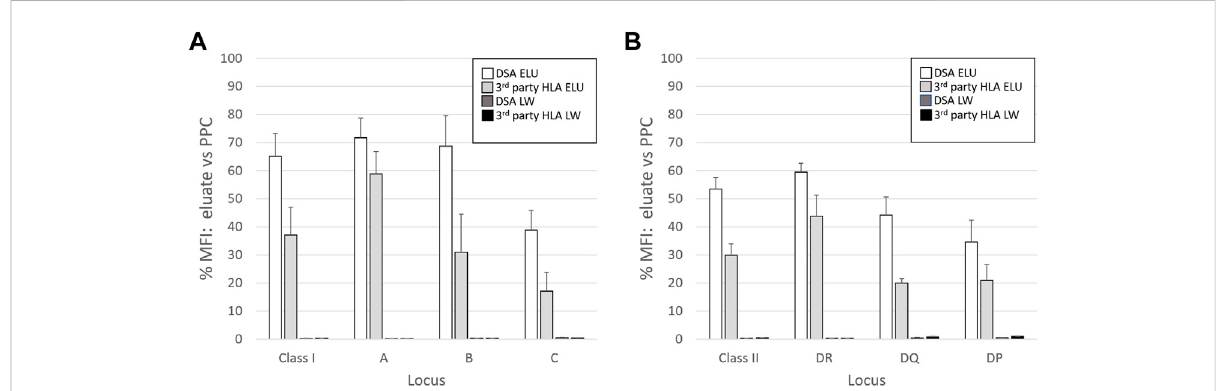
FIGURE 3 Theef fi ciencyofadsorption/elutionbyAXEisHLAlocusdependent.Themeanef fi ciency(%MFIcomparedtoserum)ofAXEadsorption/elution of DSA (DSA ELU; white bars) and 3 rd party HLA speci fi cities (3rd party HLA ELU; light grey bars), as well as the mean residual reactivity (% MFI compared to serum) in the last wash controls for the DSA (DSA LW; dark grey bars) and 3 rd party HLA speci fi cities (3 rd party HLA LW; black bars) are shown for class I (A) and class II (B) locus speci fi c HLA antibodies. The results are a mean +/- SD of separate experiments in which the AXE method was used to adsorb/elute HLA antibodies from PPC sera (1:128 dilution for class I and 1:8 dilution for class II HLA) with fi ve different donor